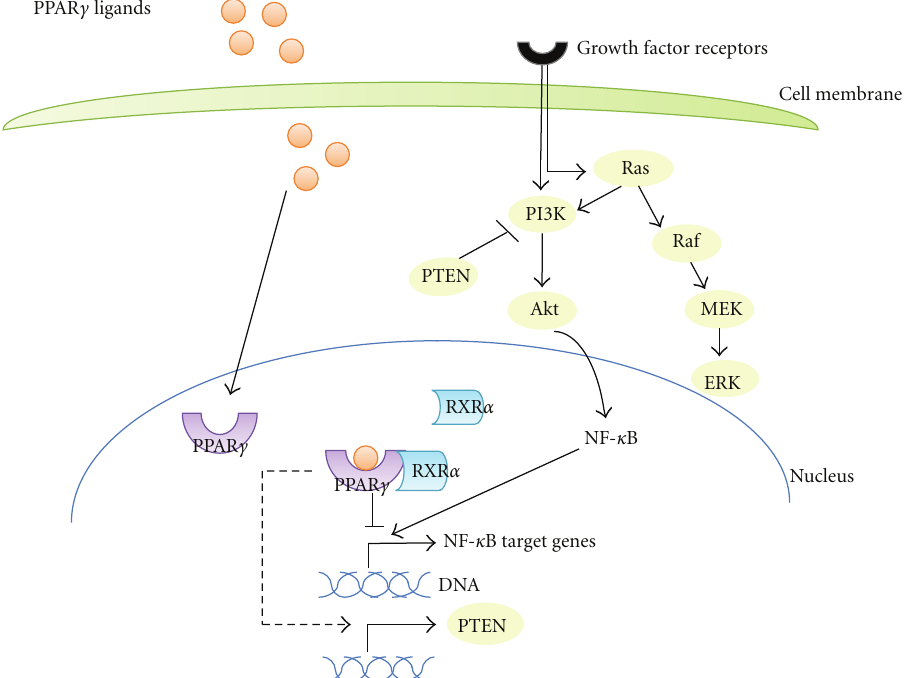
Figure 2: The role of ubiquitination and PPAR γ in the PI3K-AKT and MAPKs signaling pathways. Proteins that are regulated by ubiquitination are depicted as yellow cycles. Examples of regulation of these pathways by PPAR γ include transcriptional activation of phosphatase PTEN and antagonism of the transcriptional activity of NF- κ